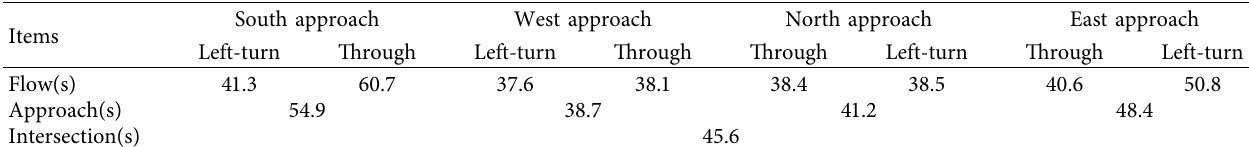
Figure 6: Two scenarios incident related. (a) An accident at upstream of the west approach. (b) An accident at downstream of the east exit. Table 6: Delay of the Hongqi Street and Huaihe Road intersection after